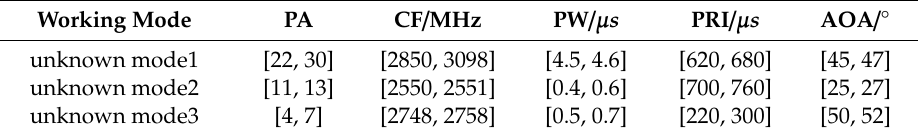
Table 2. Unknown radar characteristic parameters.